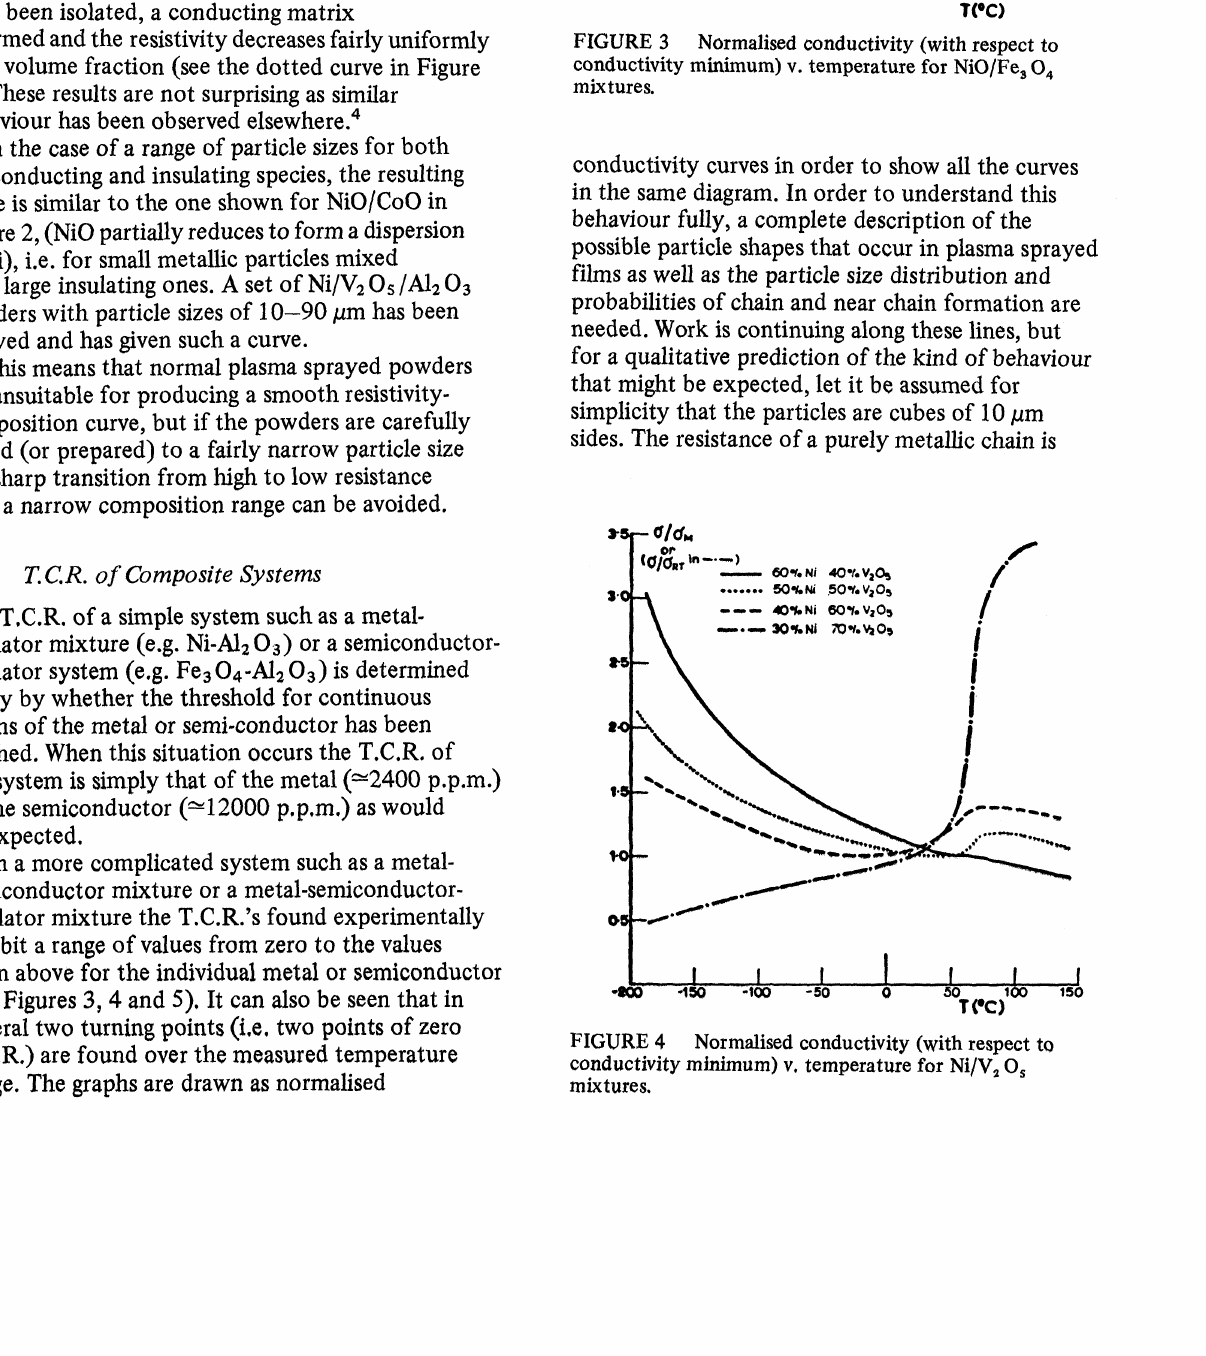
Normalised conductivity (with respect to conductivity minimum) v. temperature for Ni/V= O